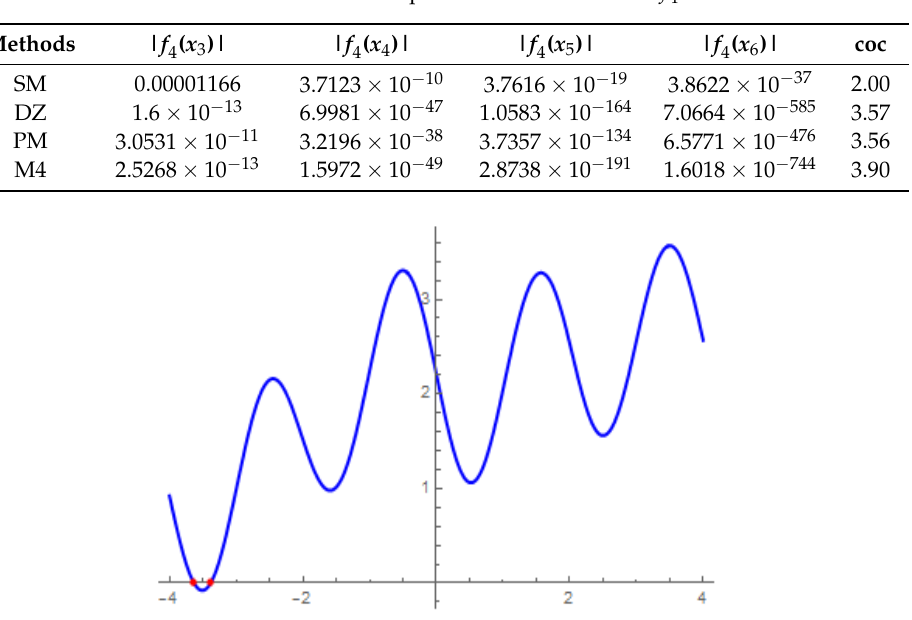
Table 4. Result of comparisons for the function 𝑓 4 .